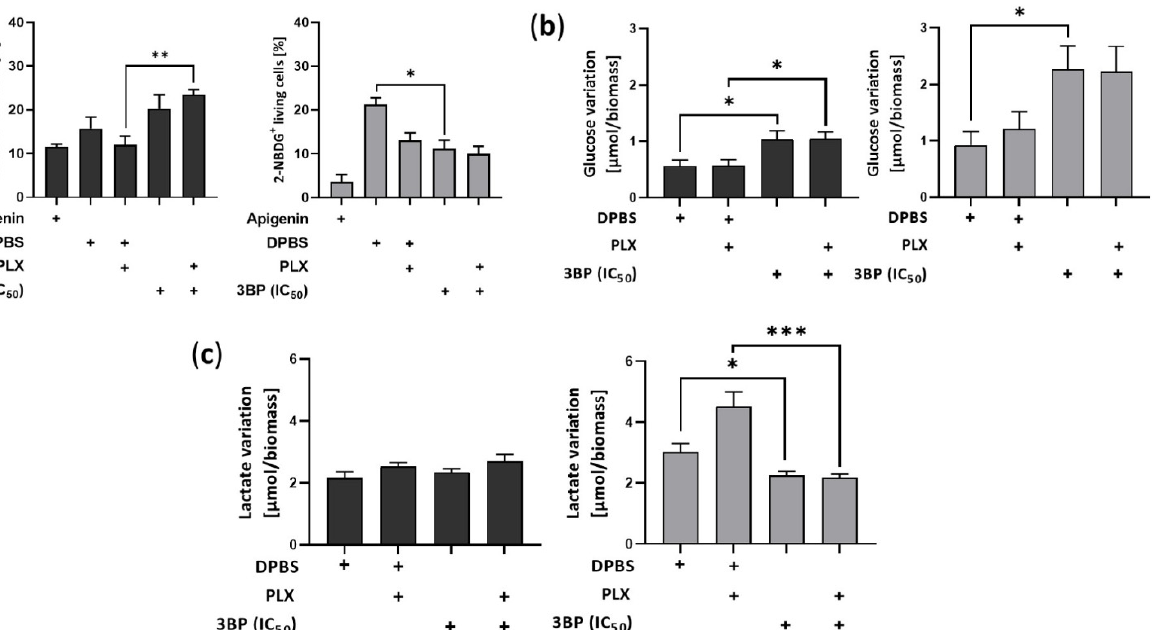
Figure 2. Expression of metabolic proteins in vemurafenib (PLX)-resistant melanoma cells treated with 3-bromopyruvate (3BP) for 24 h. ( a ) Western blot analysis of the levels of ASCT2, CA9, CD147, GLS, GLUD1/2, GLUT1, HK2, LDH5, MCT1, MCT4, and PDK in PLX-resistant melanoma cells treated with IC 50 3BP, either alone or combined with PLX (4.5 µM for A375R and 6.0 µM for SKMEL28R), for 24 h. ( b ) Quantification of immunoblots normalized to ACTB levels in A375R melanoma cells. ( c ) Quantification of immunoblots normalized to ACTB levels in SKMEL28R melanoma cells. The y -axis represents arbitrary units [a.u.]. The positive signs in the bar charts indicate the presence of a defined treatment. Data represent the mean ± SEM of at least three independent experiments. * p ≤ 0.05; ** p ≤ 0.01.